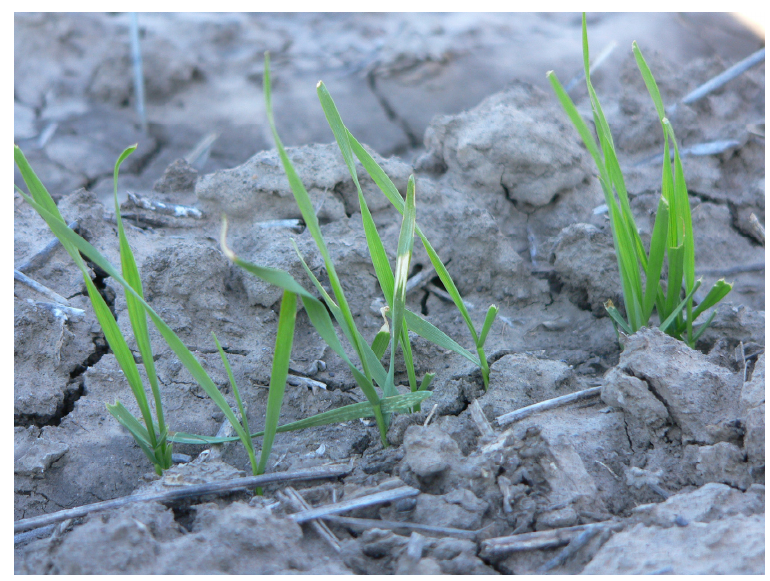
Picture 1. Sodicity–induced calcium ‐ deficiency symptoms in barley genotype Mackay. Figure 1. Sodicity–induced calcium-deficiency symptoms in barley genotype Mackay.